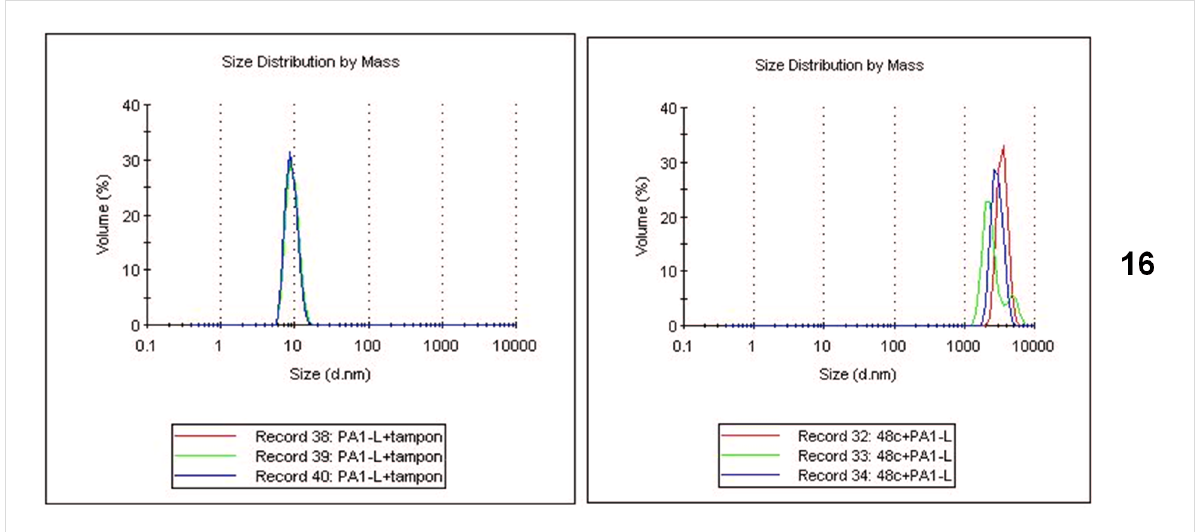
Scheme 2: Synthesis of mixed triazine-based glycoclusters.